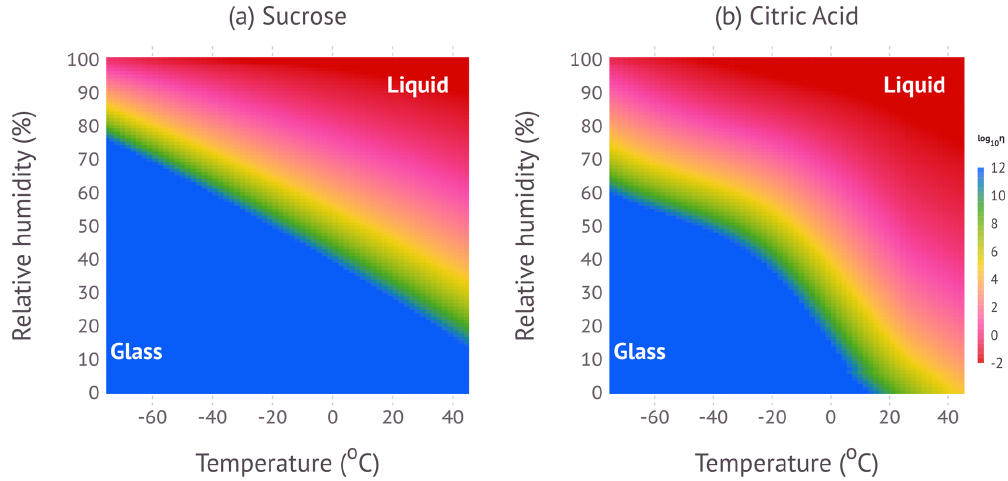
Figure 7. False-color representation of viscosity predicted by the phase diagram